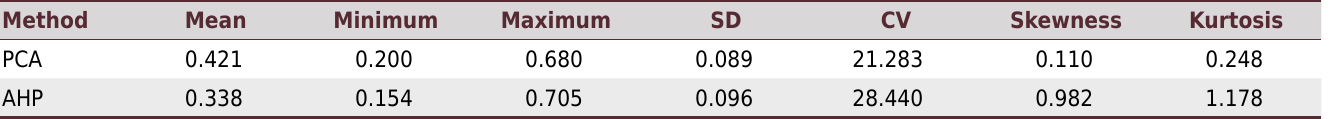
Table 5. Descriptive statistics of the integrated quality index (IQI), n = 194 Method Mean Minimum Maximum SD CV PCA